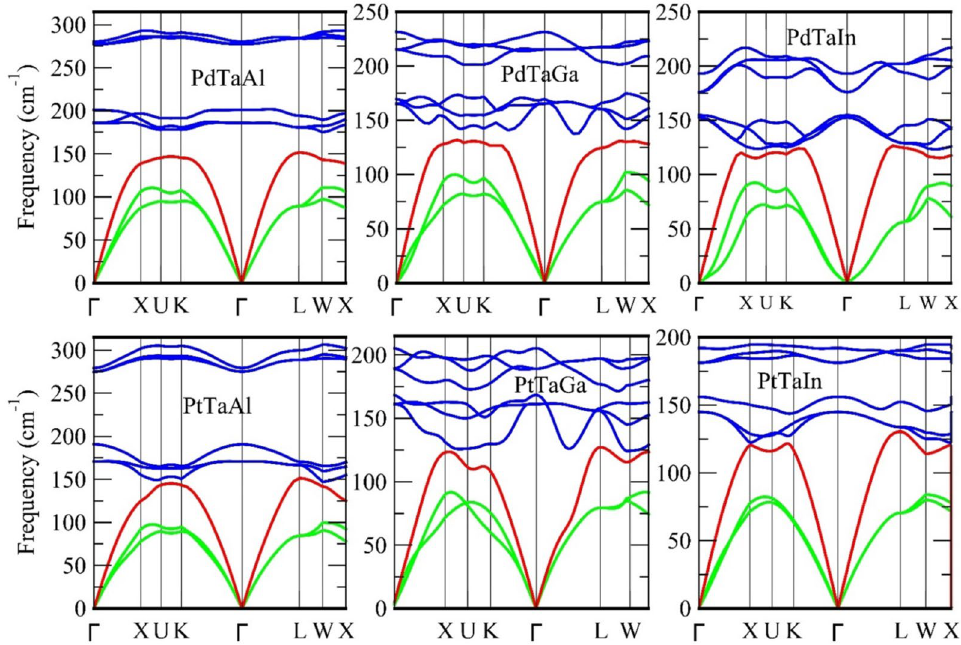
Figure 2. Phonon band structure of XTaZ alloys with no negative frequencies. Two green lines represent transverse acoustic (TA), red line indicates longitudinal acoustic (LA) and blue lines are six optical (O)